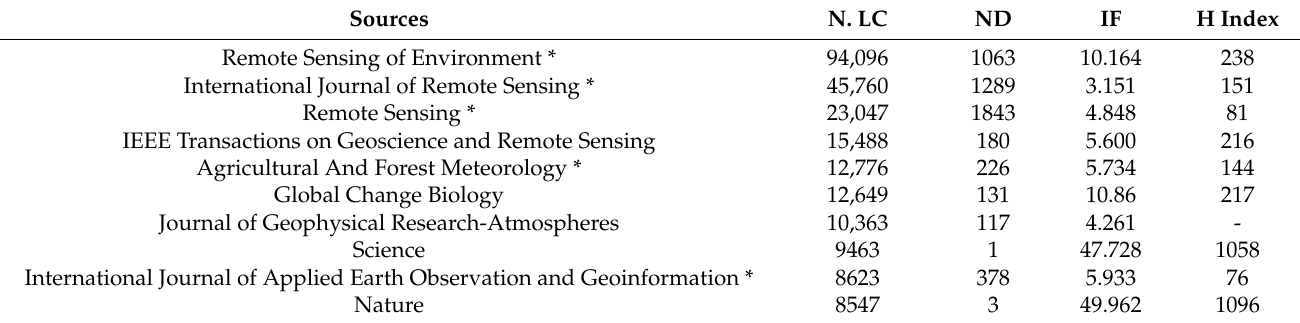
Table 4. Top ten journals ranked by the number of local citations in NDVI-related